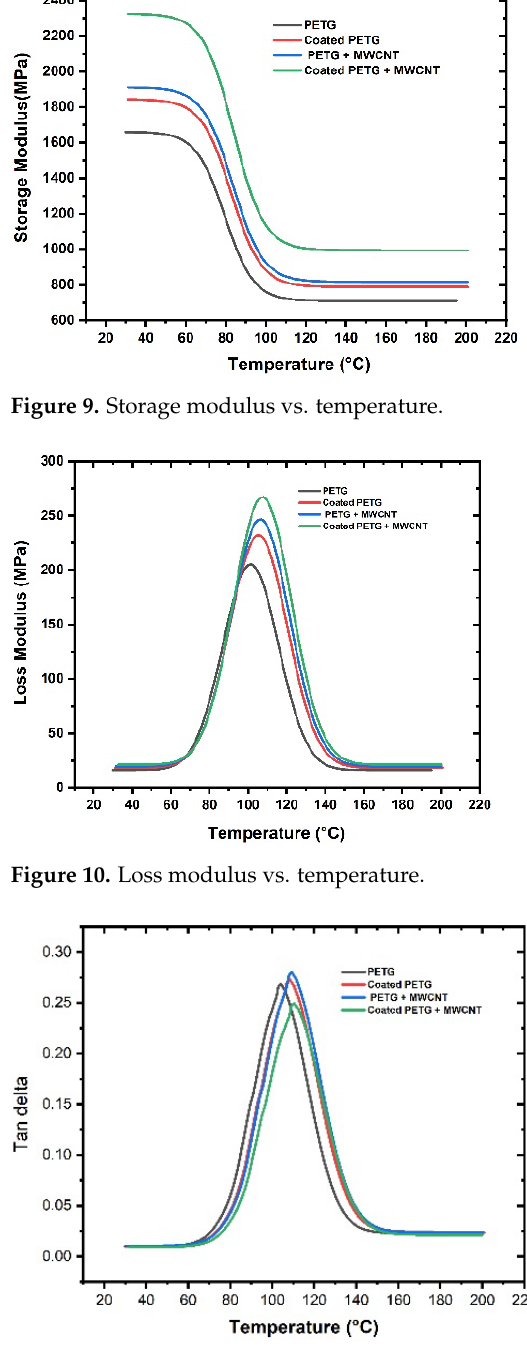
Figure 11. Tan delta vs. temperature.